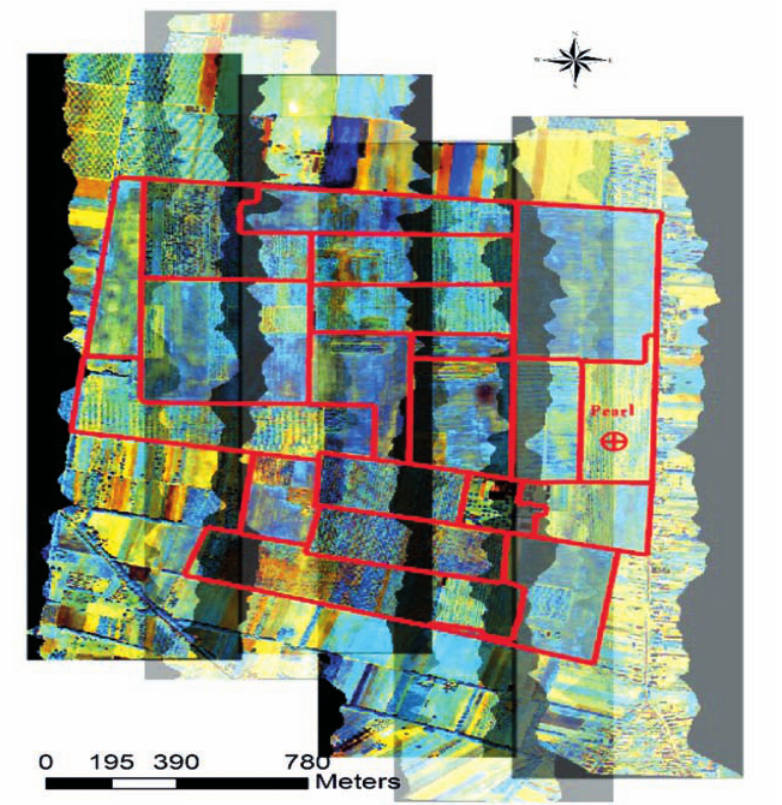
Figure1. Georectified flight strips of the hyperspectral images and the Újfehértó Research Station (Red border lines represent the borders of the parcels; Red cross shows the situation of the pear